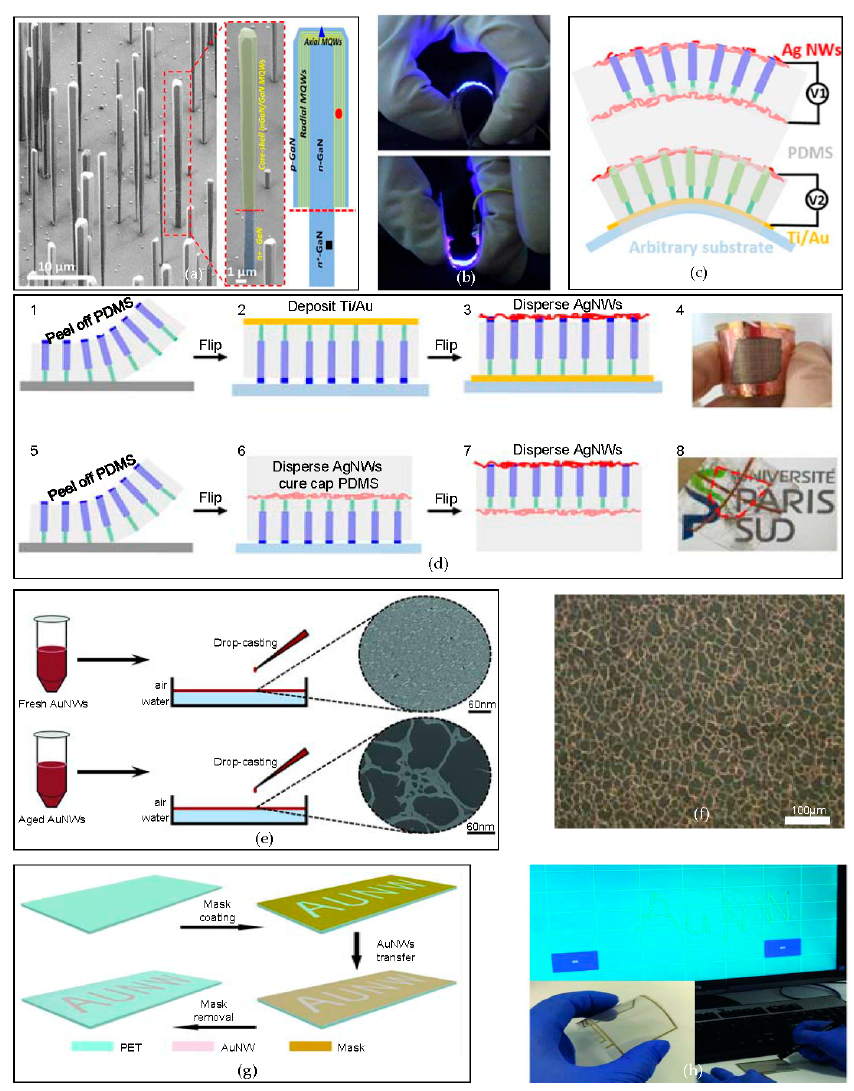
Figure 6. Flexible light emitting diodes based on vertically grown nitride nanowires/transparent and flexible nanomesh via self-assembly of ultrathin gold nanowires to fabricate a flexible touch panel. ( a ) An scanning electron microscope (SEM) image of a grown individual nanowire obtained with a tilt angle of 45°; ( b ) The flexibility of the fabricated nanowire blue LED; ( c ) A schematic of the bi-layer flexible LED with a blue LED for the top layer and a green LED for the bottom layer; ( d ) A schematic of the fabrication process for the semitransparent LED (1–4) and fully transparent LED (5–8), Reproduced with permission from 2015 Nano Letters [93]; ( e ) A transmission electron microscopy (TEM) image of a gold nanowires (AuNW) nanomembrane fabricated by a fresh AuNW solution and an SEM image of a AuNW mesh film fabricated from an aged AuNW solution; ( f ) An optical image of the AuNW mesh film with pores fabricated by the self-assembly method from an aged AuNW solution; ( g ) A schematic of the patterning of the AuNW mesh film on PET; and ( h ) A flexible touch panel fabricated using the AuNW mesh film. Reproduced with permission from 2016 Advanced Electronic Materials [90].